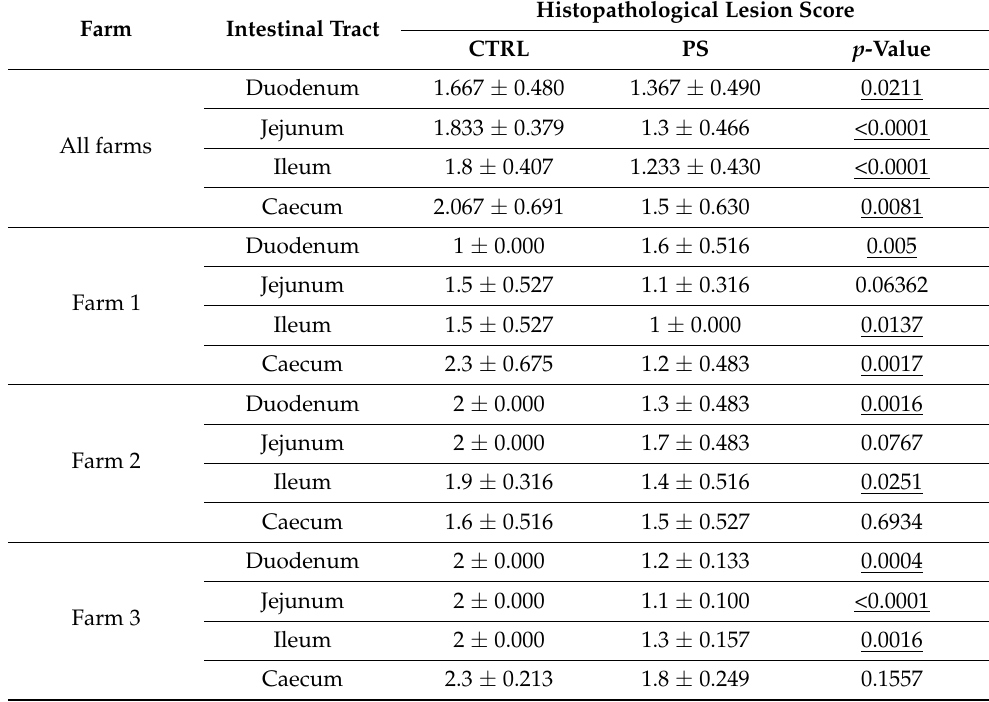
Table 1. Mean ± standard deviation of the histopathological lesion scores measured at duodenum, jejunum, ileum and caecum level of treated (PS) and control (CTRL) birds. Scores are reported on a scale from 0 (absent or rare leukocytic infiltration) to 3 (leukocytic infiltration in the range of 50% of a ×400 field). p -values below 0.05, marking the statistical significance of a difference observed when comparing treatment and control groups across all farms or in each farm individually, are under- lined.